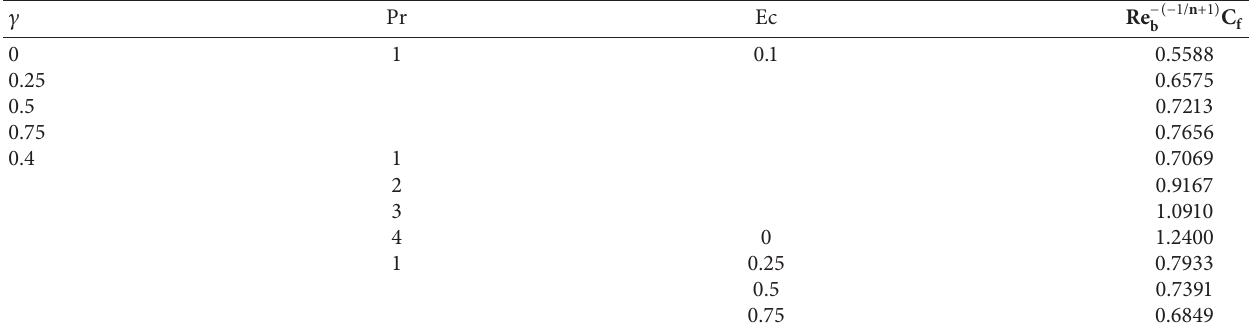
Table 4: Nusselt number for c , Pr, and Ec for n � 1